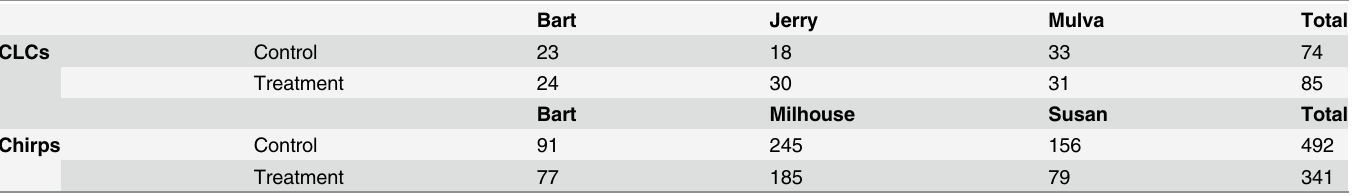
Table 1. Numbers of CLCs and chirps produced by each subject during the “ test ” periods summed over all six noise types (total of 12 trials per subject).